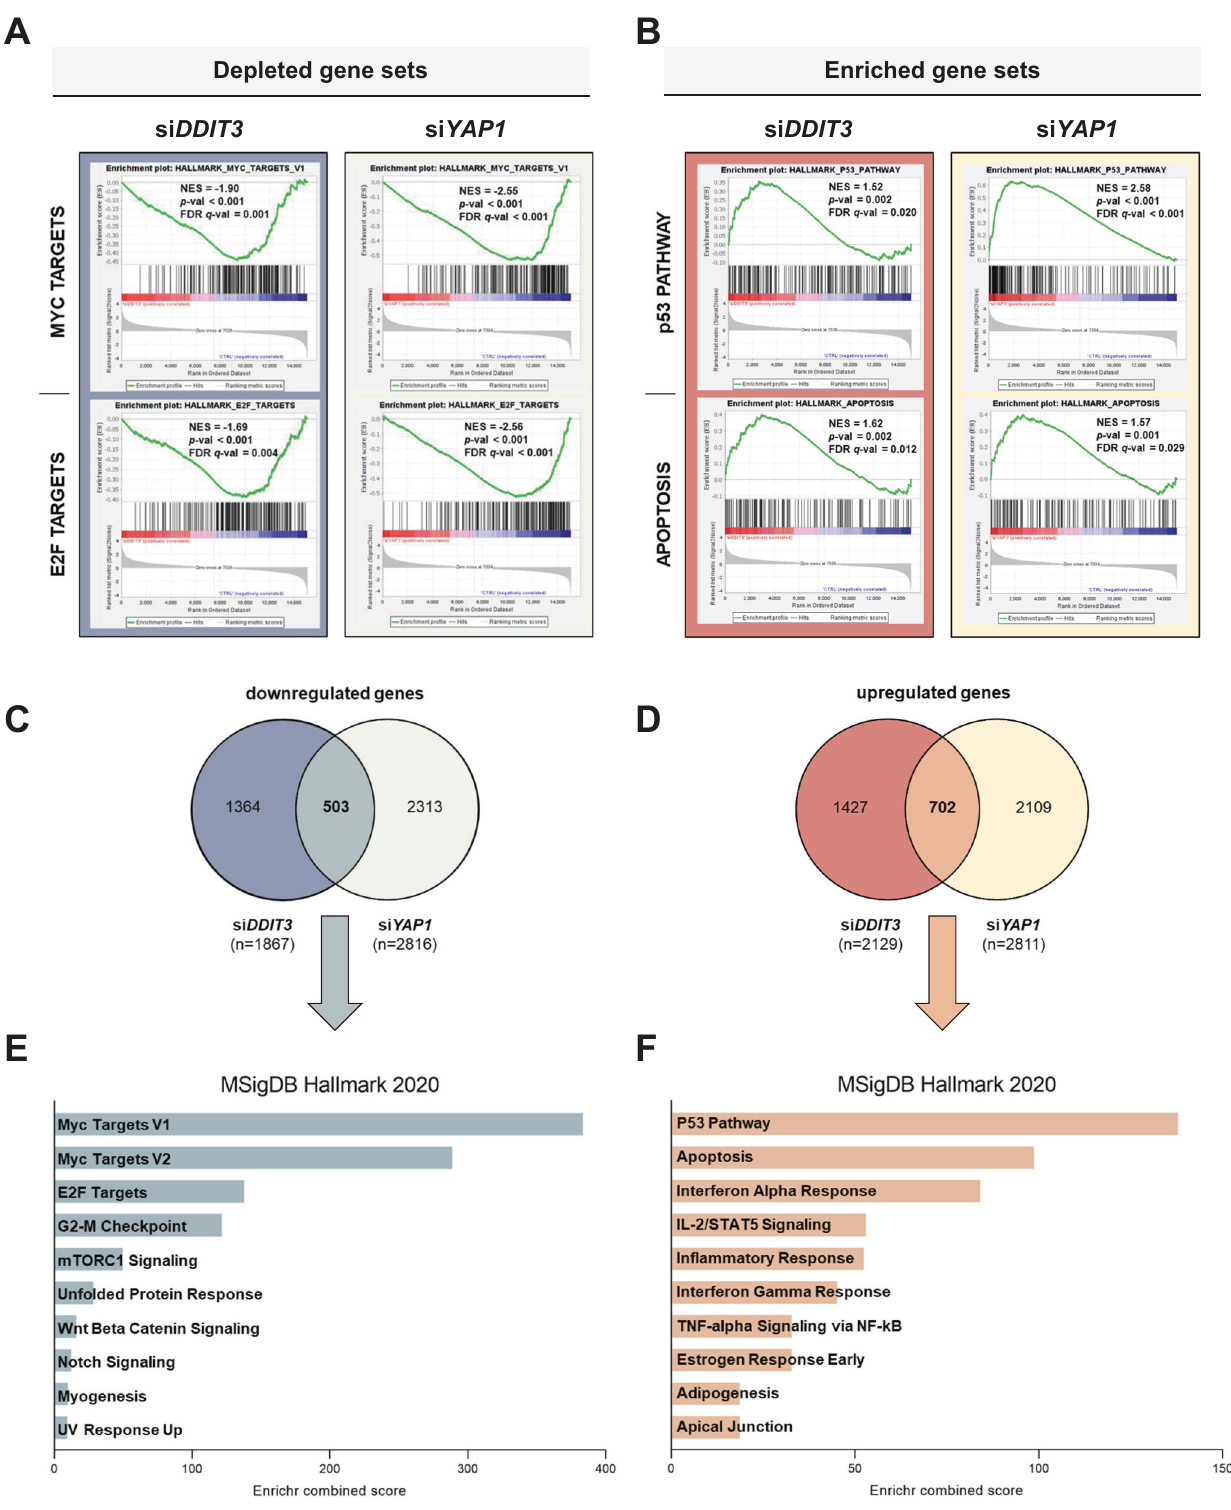
Fig. 4 RNA-seq analysis of MLS 402-91 cells upon RNAi-mediated silencing of FUS-DDIT3 and YAP1 . A GSEA plots illustrate top depleted ‘ Hallmark ’ gene sets shared by the si DDIT3 and si YAP1 conditions, showing downregulation of MYC and E2F targets in MLS 402-91 cells. B Signi fi cantly enriched gene sets co-regulated by FUS-DDIT3 and YAP1 are associated with apoptosis and p53 pathways. The normalized enrichment score, nominal P value and false discovery rate q -value are shown. C In total, 1867 differentially expressed genes were signi fi cantly downregulated in the si DDIT3 condition, 2816 genes were downregulated in the si YAP1 condition, and the overlap of both conditions comprised 503 genes. D The set of shared upregulated genes between the si DDIT3 ( n = 2129) and si YAP1 ( n = 2811) samples comprised 702 genes. E , F Enrichr analysis of si DDIT3 - and si YAP1 -co-regulated genes showing the top down- and upregulated pathways derived from MSigDB Hallmark